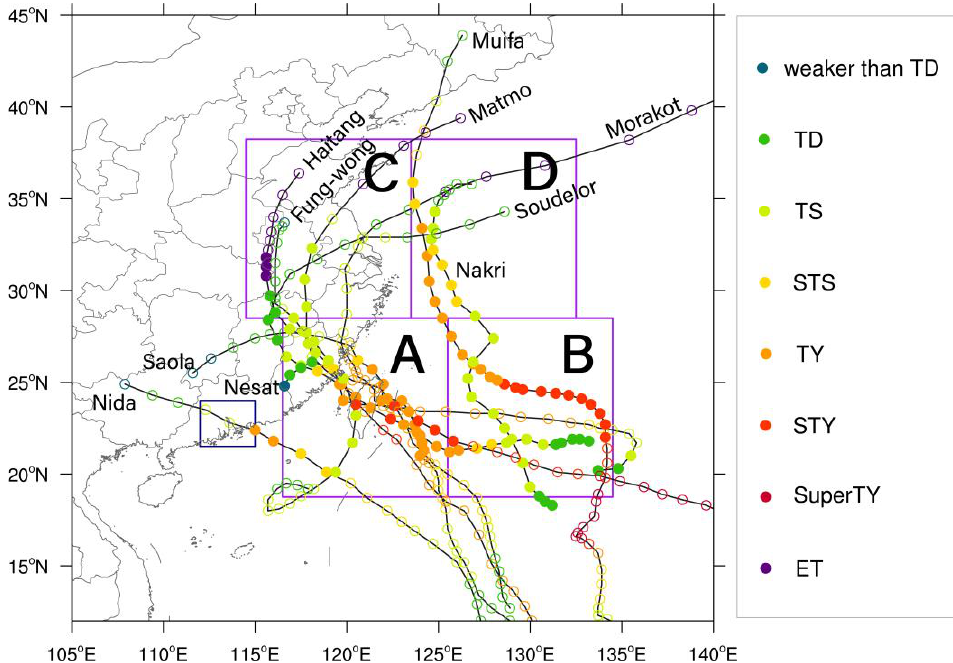
Figure 7. Tracks of the ten TCs associated with the PRD-only regional heatwave. The filled and hollow circles denote the TC centers at 6 h intervals on the heatwave days and the other days, respectively, with colors denoting the intensity of TC estimated by CMA: tropical depression (TD), tropical storm (TS), severe tropical storm (STS), typhoon (TY), severe typhoon (STY), super typhoon (SuperTY), and extratropical transition (ET). Purple rectangles denote the four regions where the TCs are centered. Navy rectangle shows the PRD region. Gray lines indicate the national and provincial boundaries and coastlines. A to D represent four regions divided according to different locations of TCs.